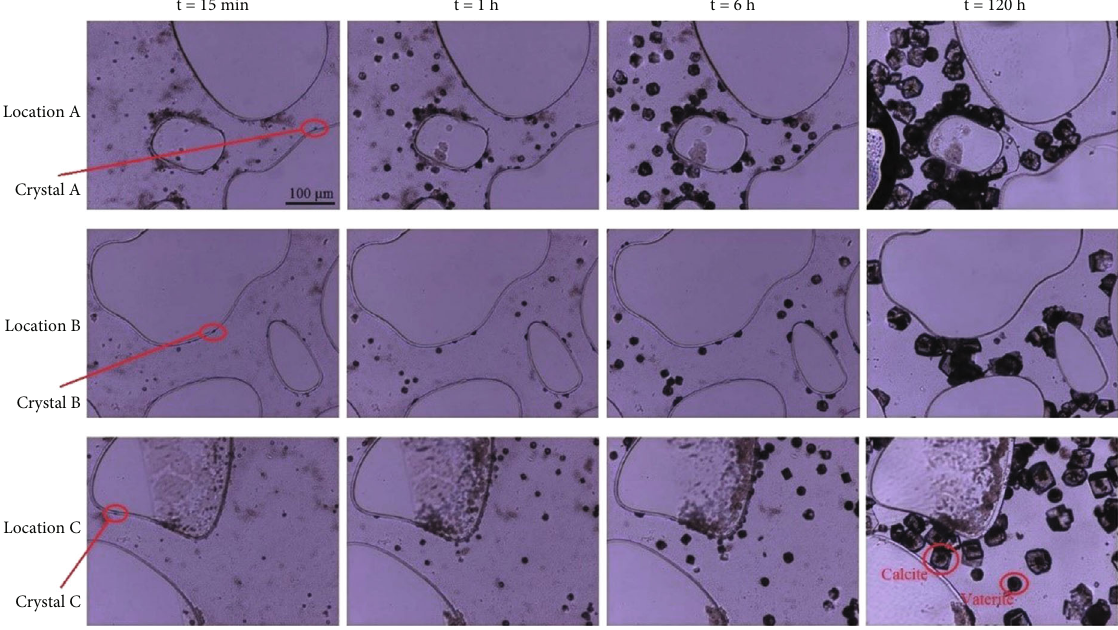
Figure 4: Results of Test 1 portraying the MICP process in the micro fl uidic porous chips.